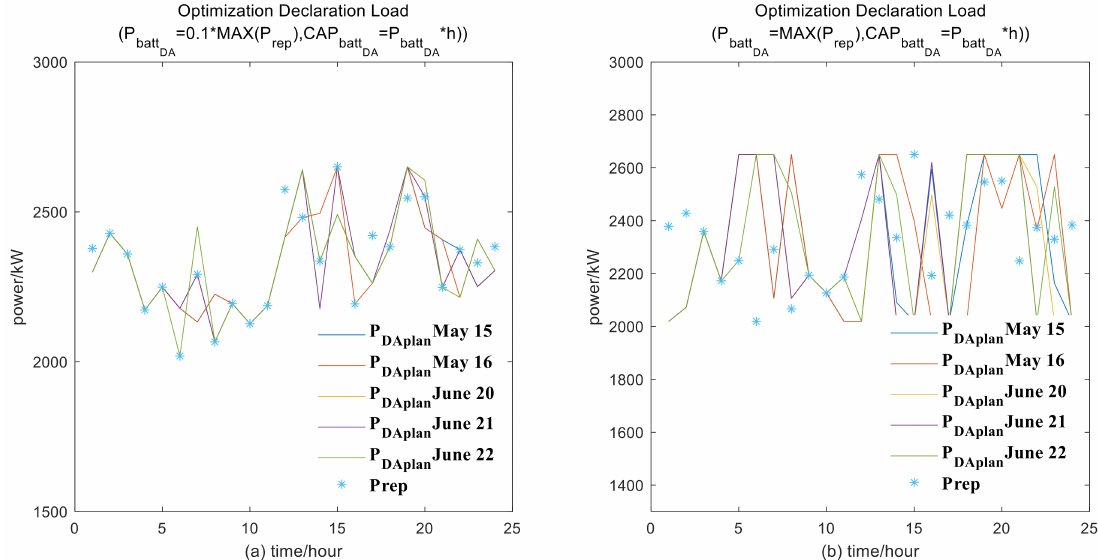
Figure 7. Optimization of DA declared load curve.